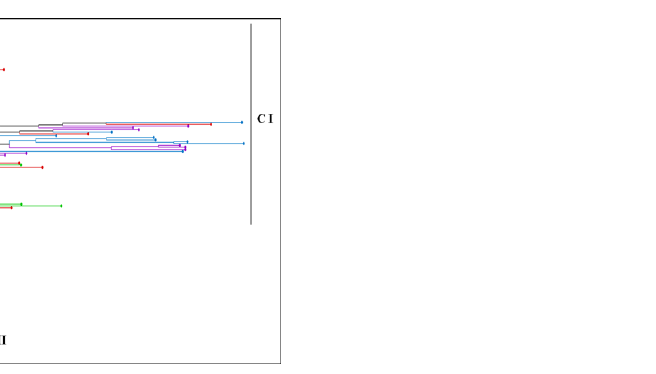
Fig 1. Unweighted Neighbor-joining tree using the simple matching similarity coefficient based on 23 microsatellite markers for the 163 isolates of Colletotrichum gloeosporioides isolated from citrus in Ethiopia. The tree shows the clustering pattern of isolates from the four C . gloeosporioides populations. The populations are color coded as follows: Central region ( red ), Northwest region ( green ), South region ( blue ) and Southwest region ( violet ).